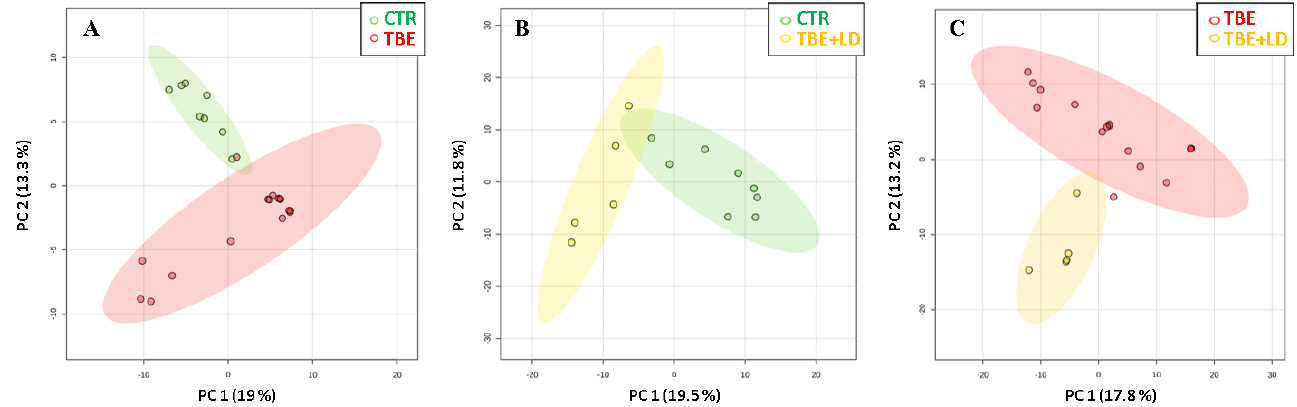
Figure 2. Principal component analysis (PCA) of plasma samples of patients with tick-borne en- cephalitis (TBE, n = 16) and patients with TBE and co-infection (TBE+LD, n = 5), as well as healthy donors constituting the control group (CTR, n = 8). The charts show the grouping of samples when analyzed CTR with TBE ( A ); CTR with TBE+LD ( B ), and TBE with TBE+LD ( C ).